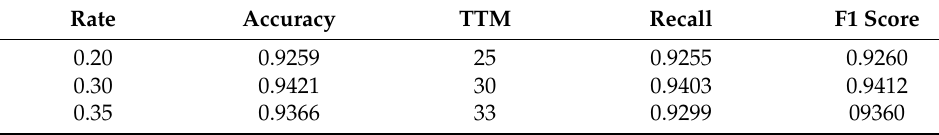
Table 3. Performance evaluation of the different rates for dropout layer.